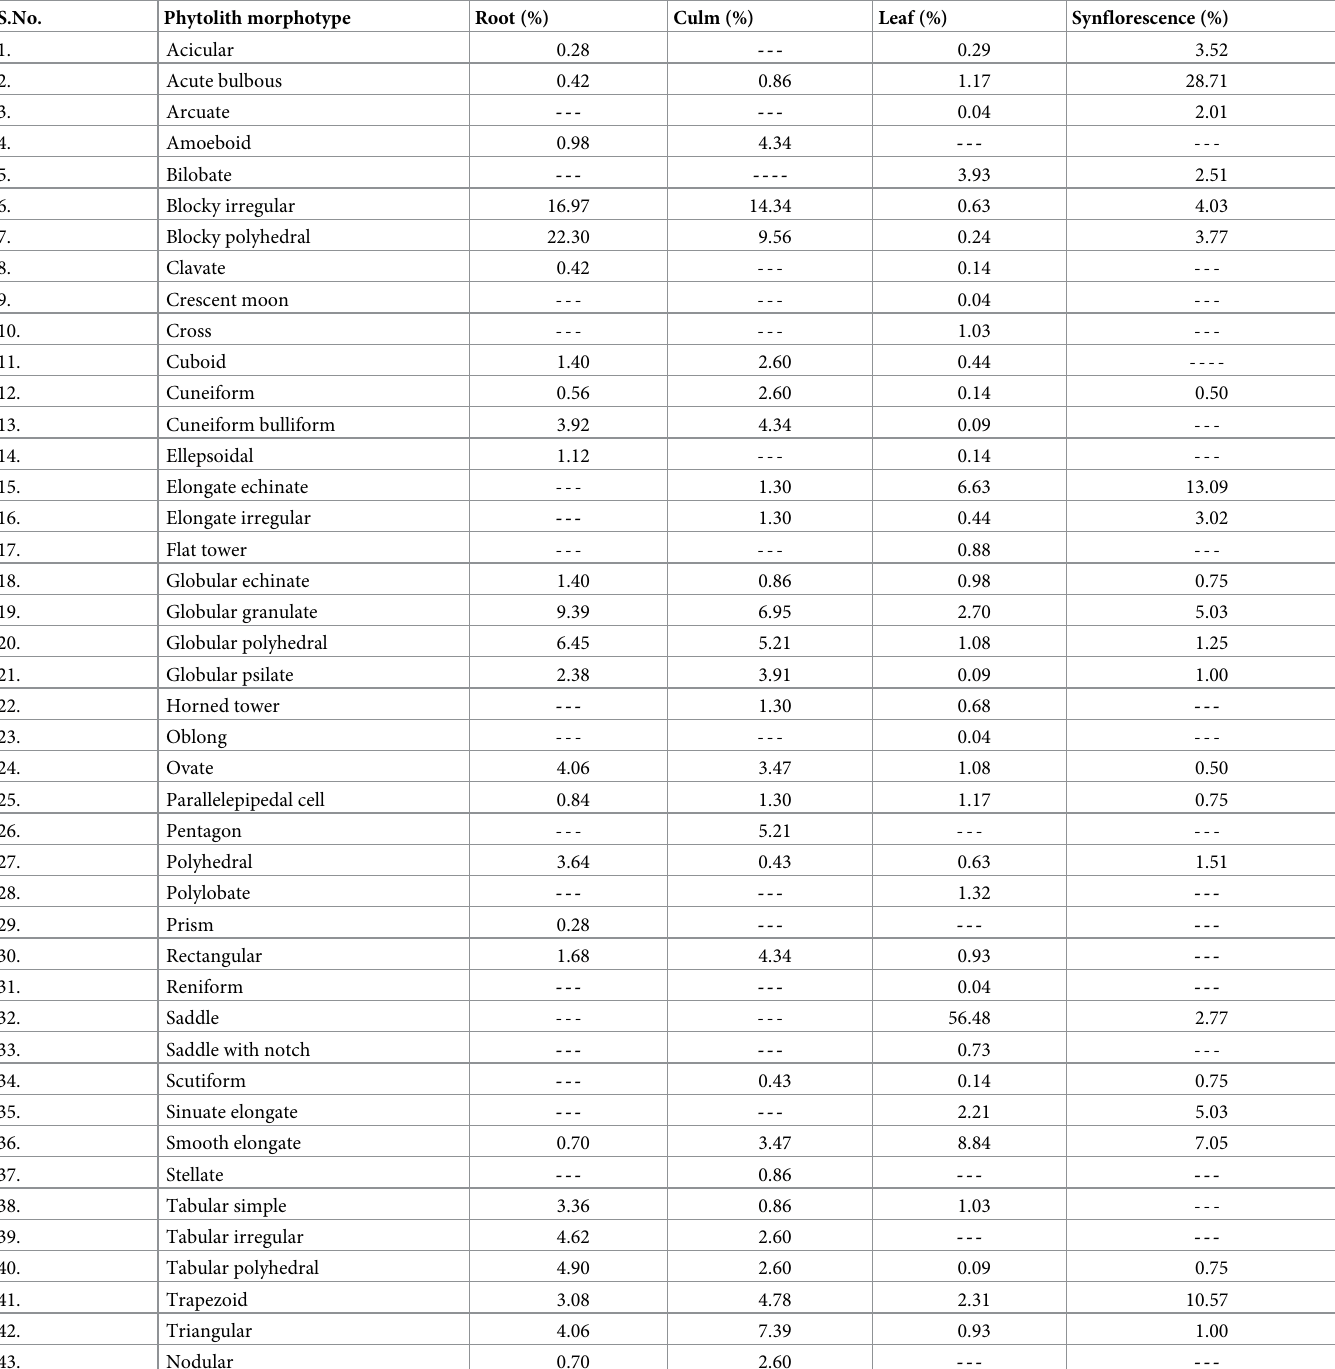
Table 6. Frequency distribution of phytolith morphotypes from different parts of the Acrachne racemosa (Heyne ex Roem. & Schult.) Ohwi.